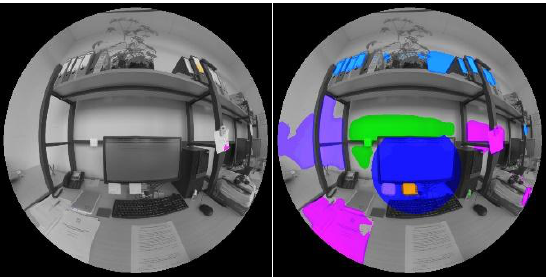
Figure 42. Extreme example (field study) of the difference in glare source(s) detection resulting from the b1000_Lb setting ( left ) and the t3_smoothed setting ( right ) in evalglare.